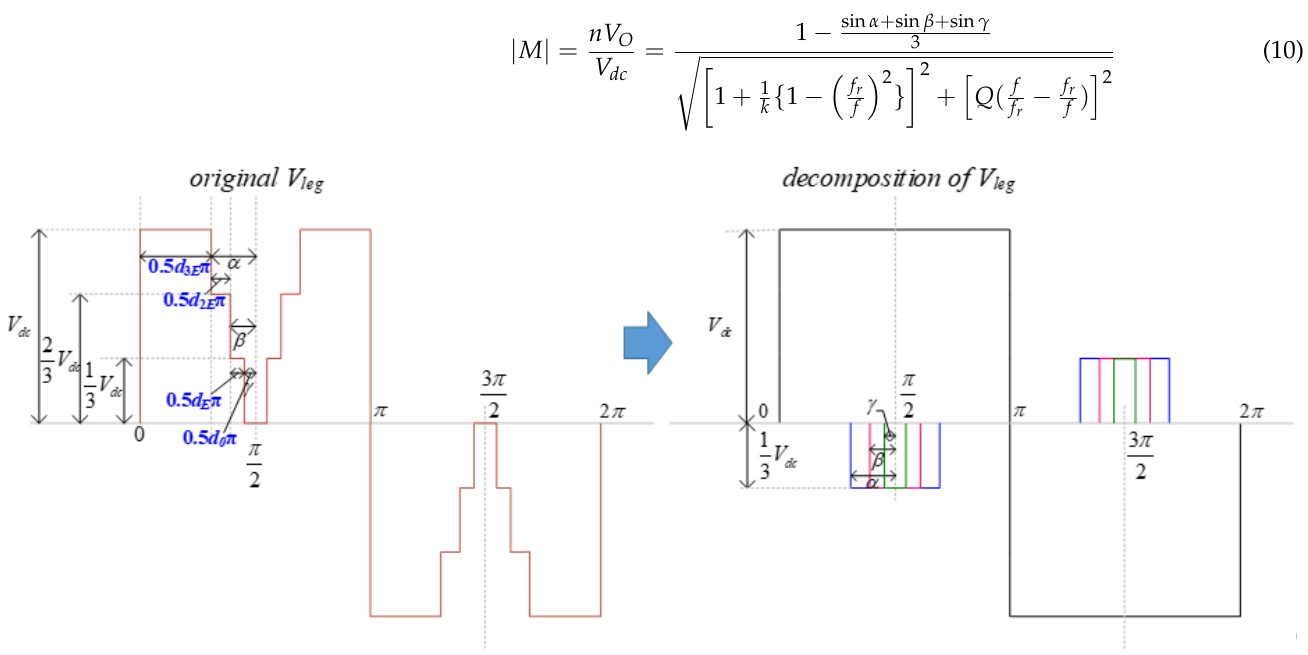
Figure 10. Decomposition of V leg according to the voltage sag